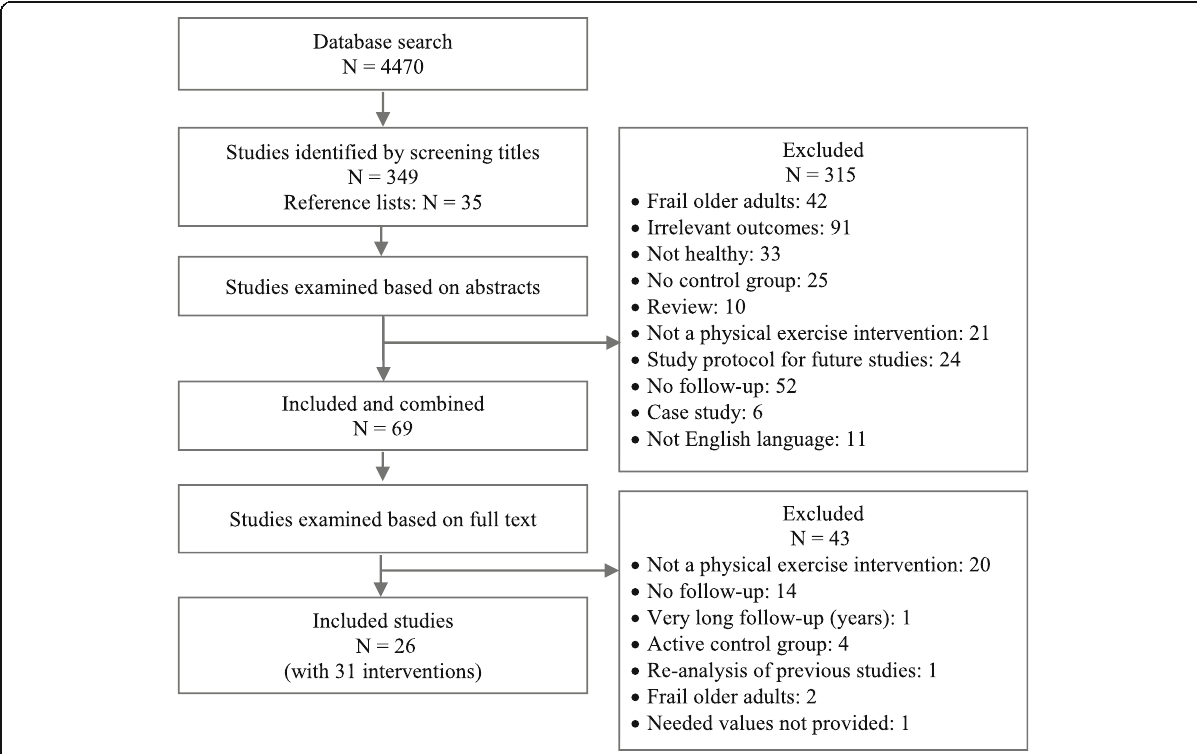
Fig. 1 Flowchart of the systematic review